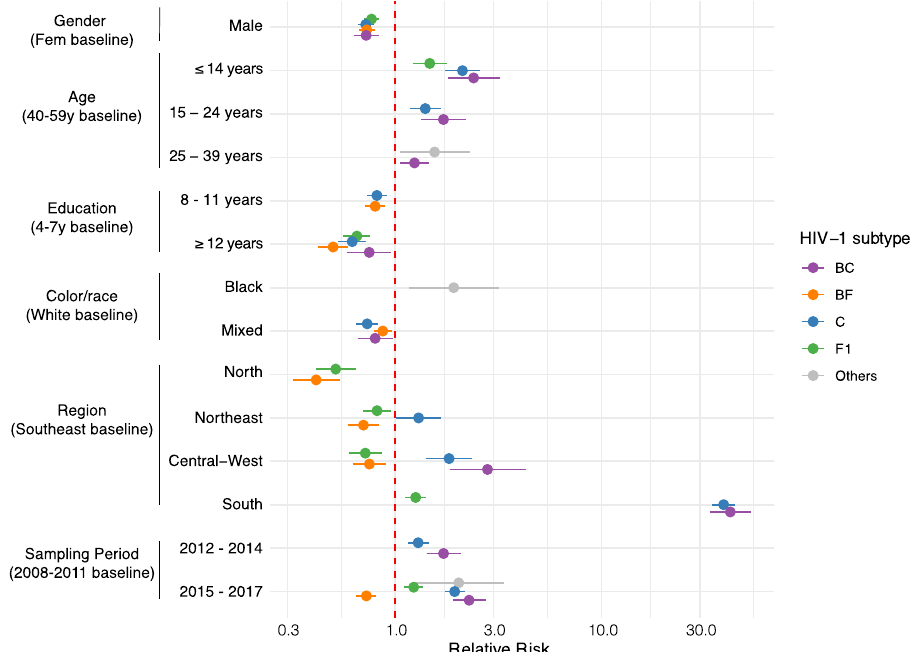
Figure 3. Relative risk of HIV-1 subtypes and main recombinant forms among RENAGENO sampled population. Relative risk and 95% confidence interval were calculated in a multinomial logistic regression model with HIV-1B as the baseline. Baseline level for each social demographic variable are between brackets. Only statistically significant ( p < 0.05) associations are shown.